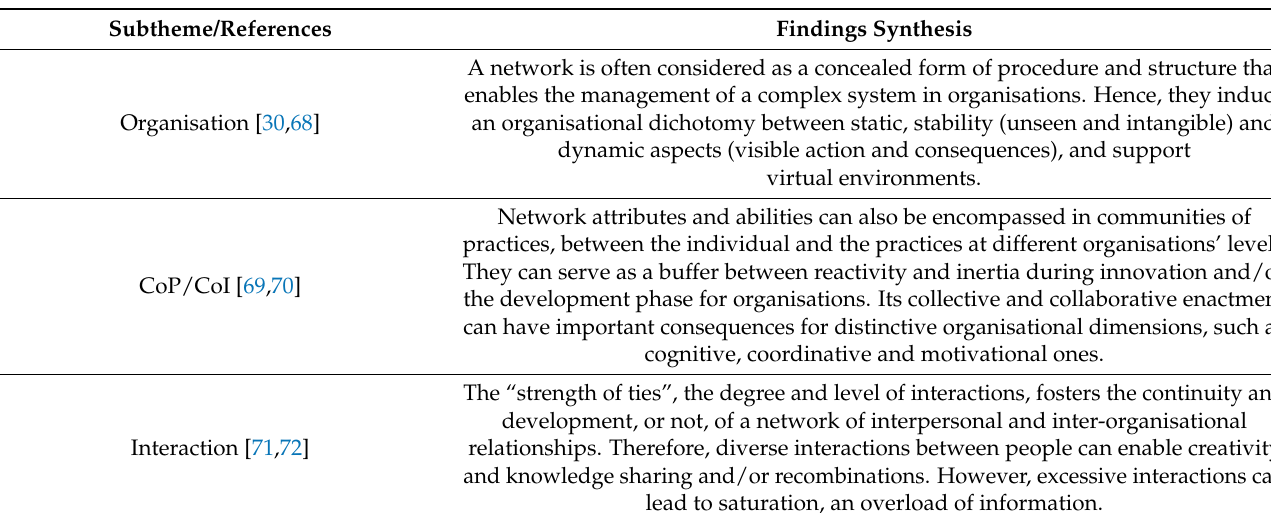
Table 2. Networks and mobile devices, or creativity on the